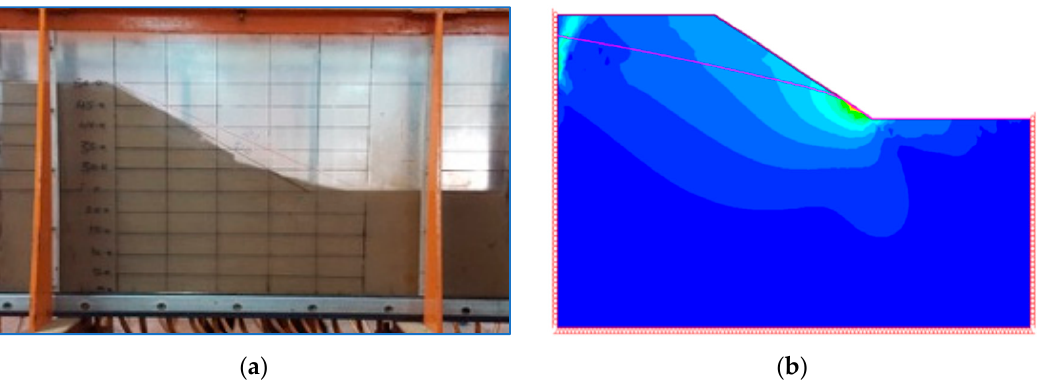
Figure 10. Side slope deformation ( a ) experimental model Al-Quamhawy (2016) [45] and ( b ) the current numerical model.